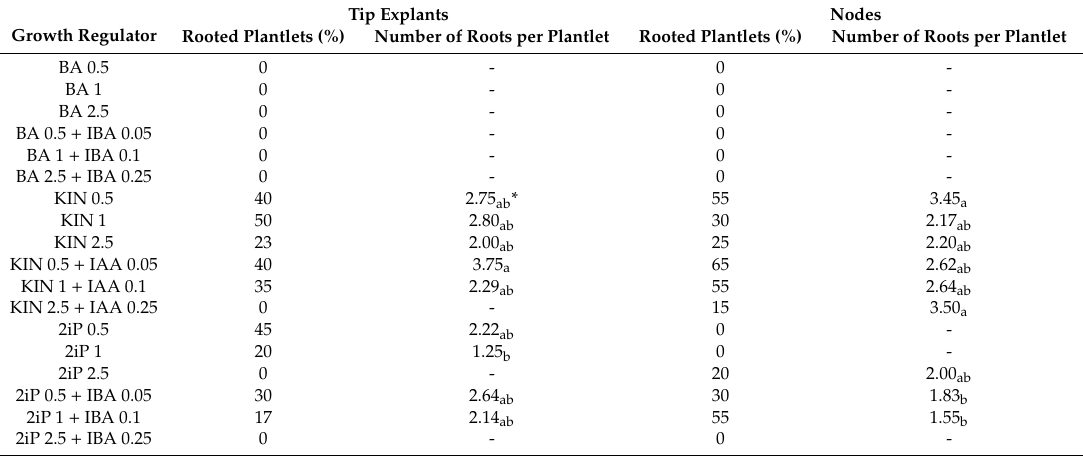
Table 4. Rooting of S. lapponum shoots in tissue culture depending on the growth regulators added to the medium.